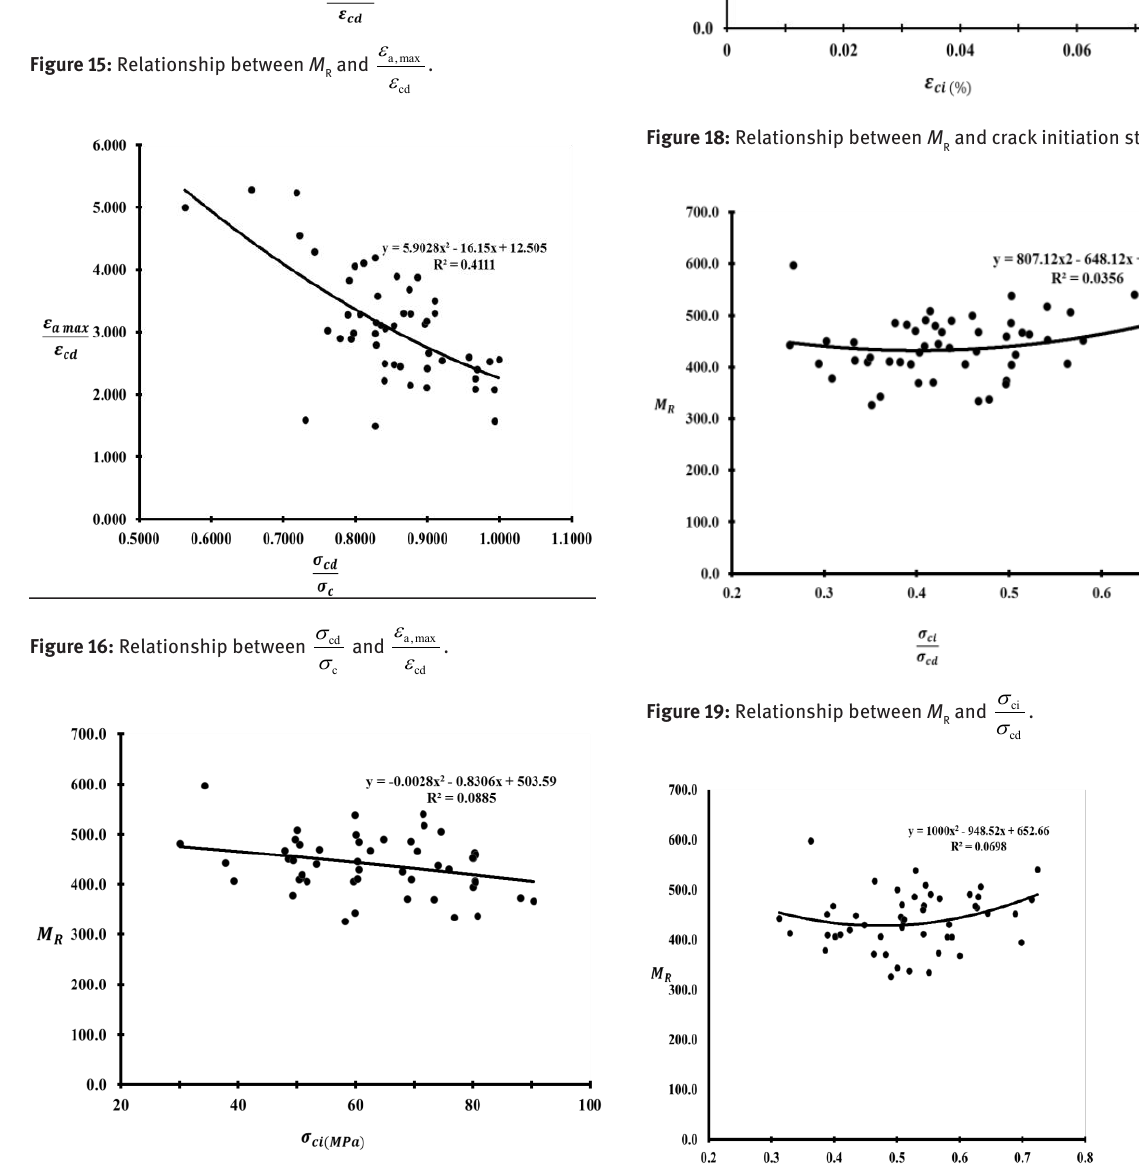
Figure 17: Relationship between R M and crack initiation stress ( ci s ). Fig .17. Relationship between initiation stress(